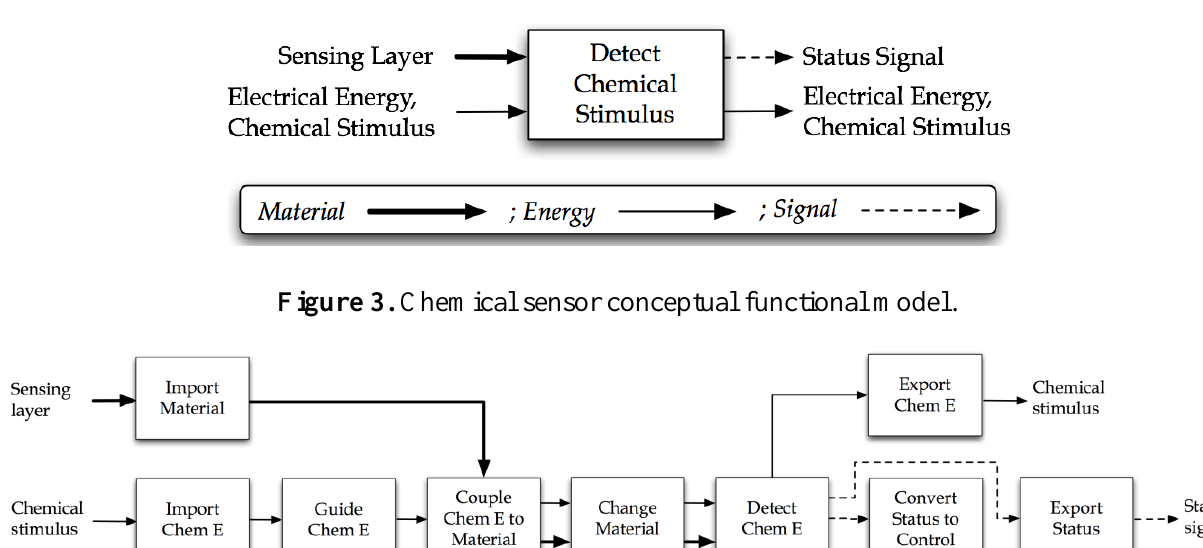
Figure 2. Chemical sensor black box model.